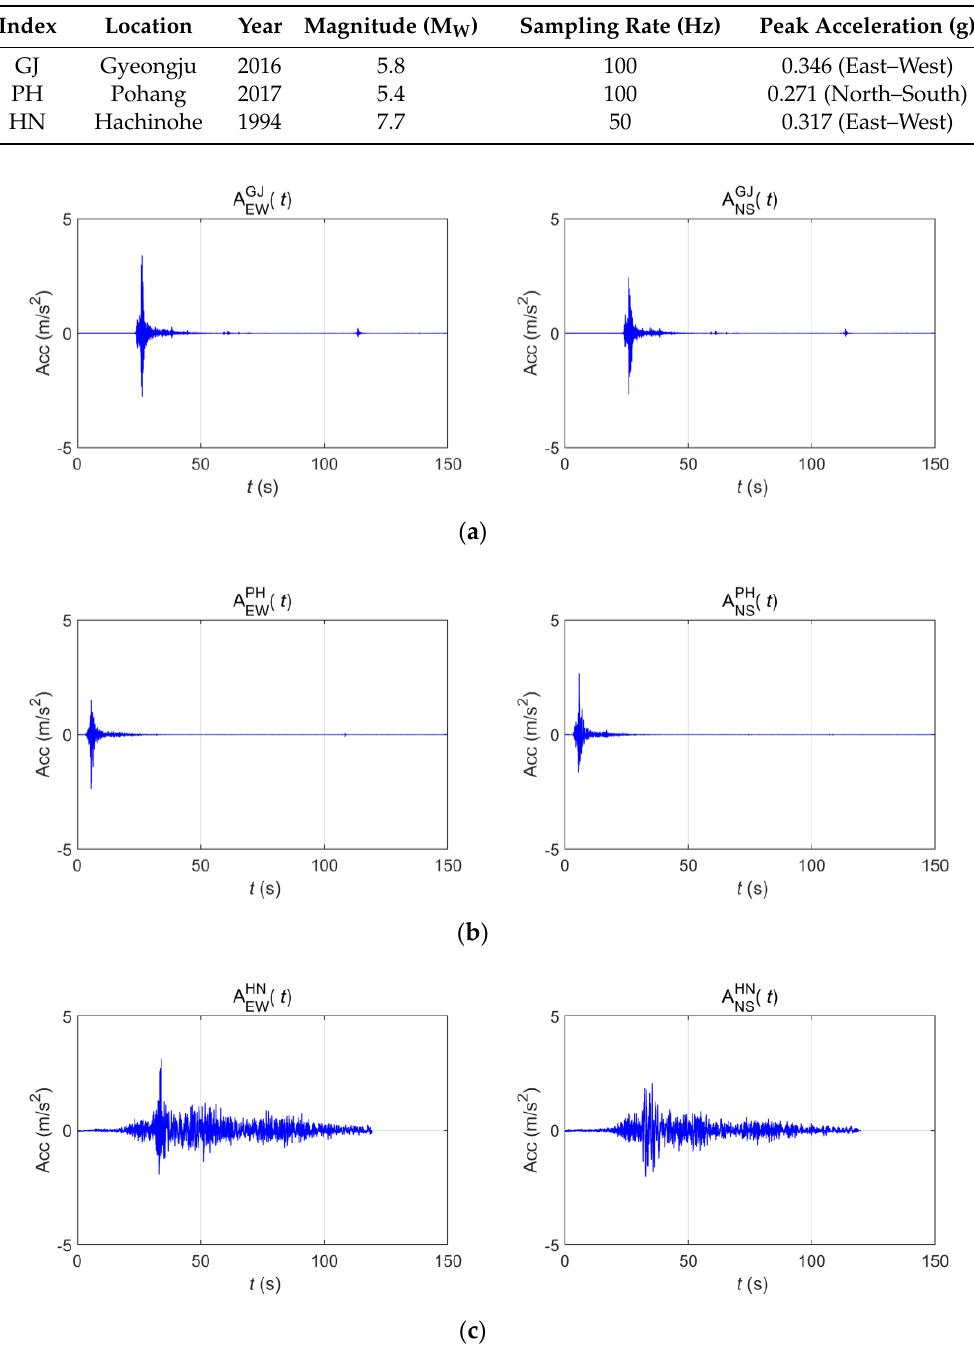
Figure 3. Measured acceleration time series of ( a ) Gyeongju (2016), ( b ) Pohang (2017), and ( c ) Hachinohe (1994).